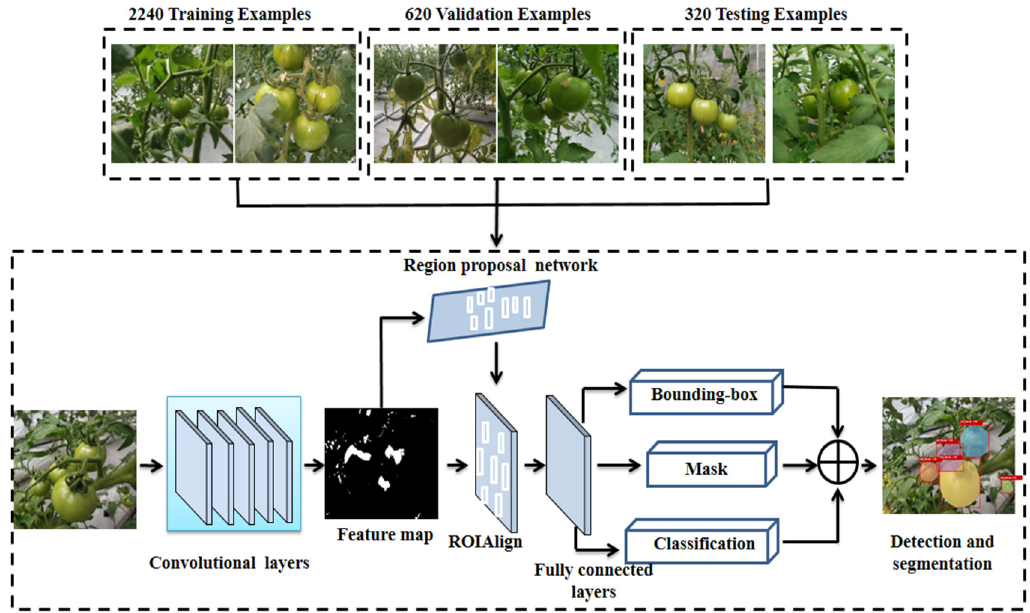
Figure 5. The structure of tomato detection and segmentation based on Mask